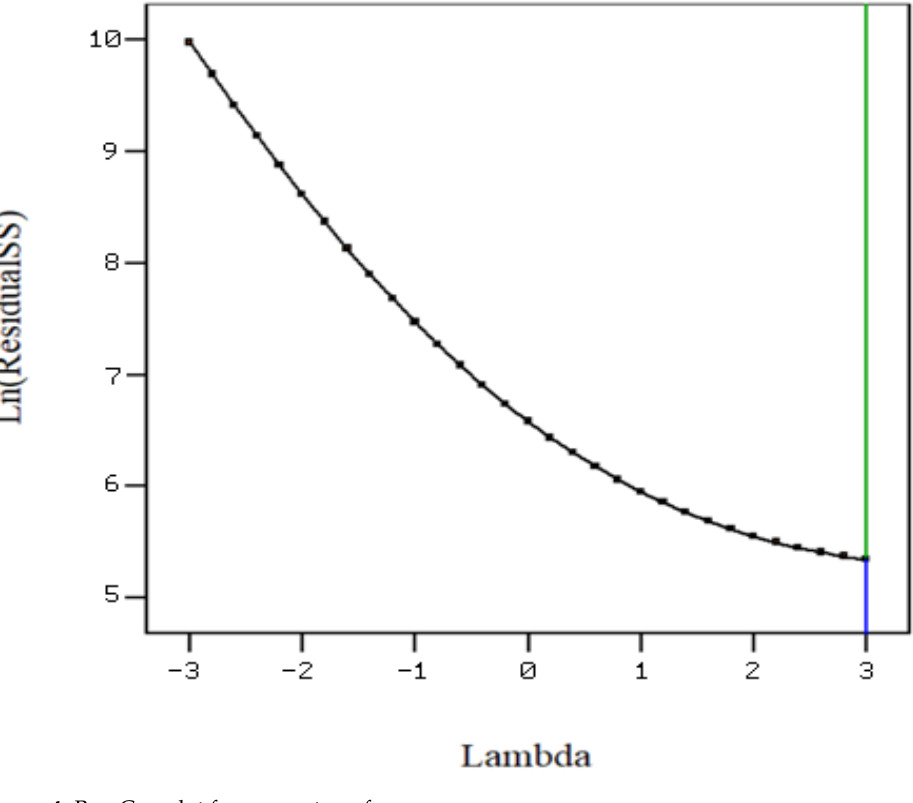
Figure 4. Box-Cox plot for power transform. The coefficients of Equation (2) were determined by the CCD approach for chicken feet oil biodiesel. Equation (3) is obtained in terms of coded values to estimate the